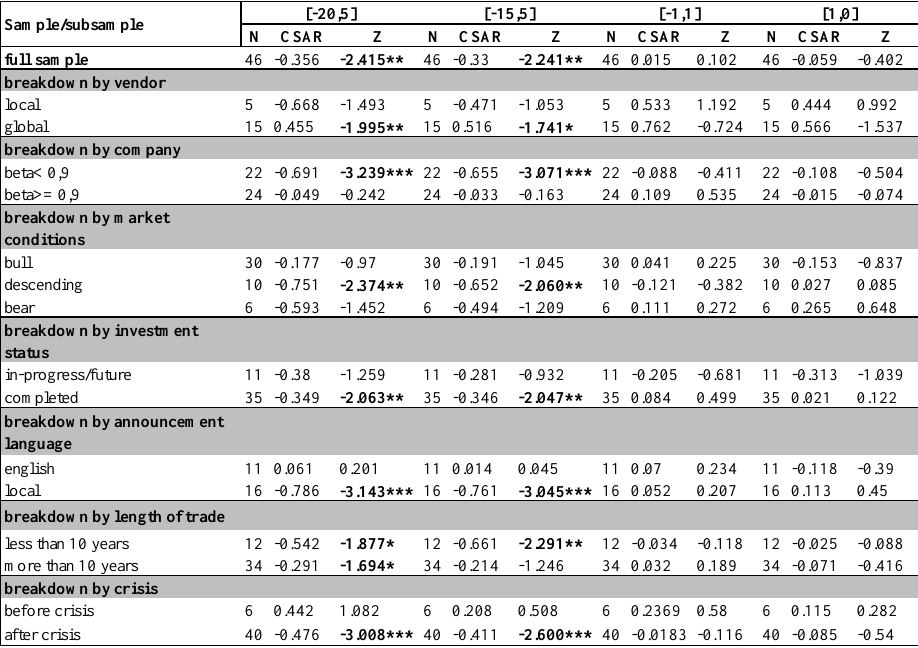
Table 2 – Summary of results from Czech Republic